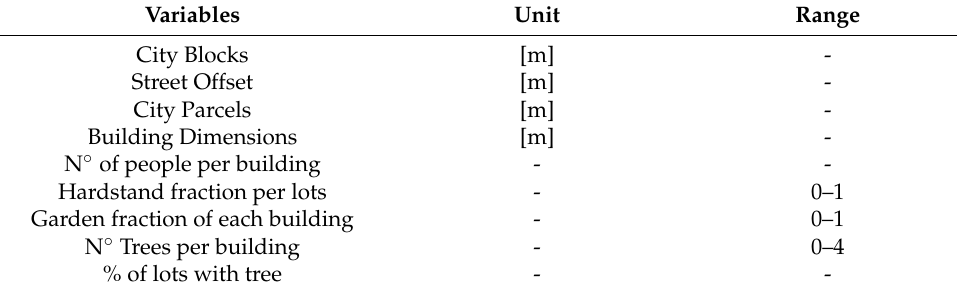
Table 2. Model input data.